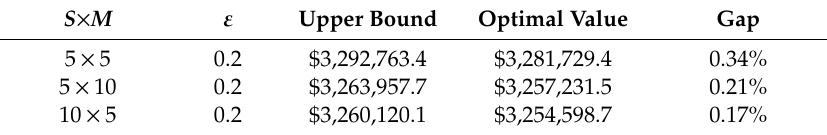
Table 10. Cost of system operation of di ff erent iteration